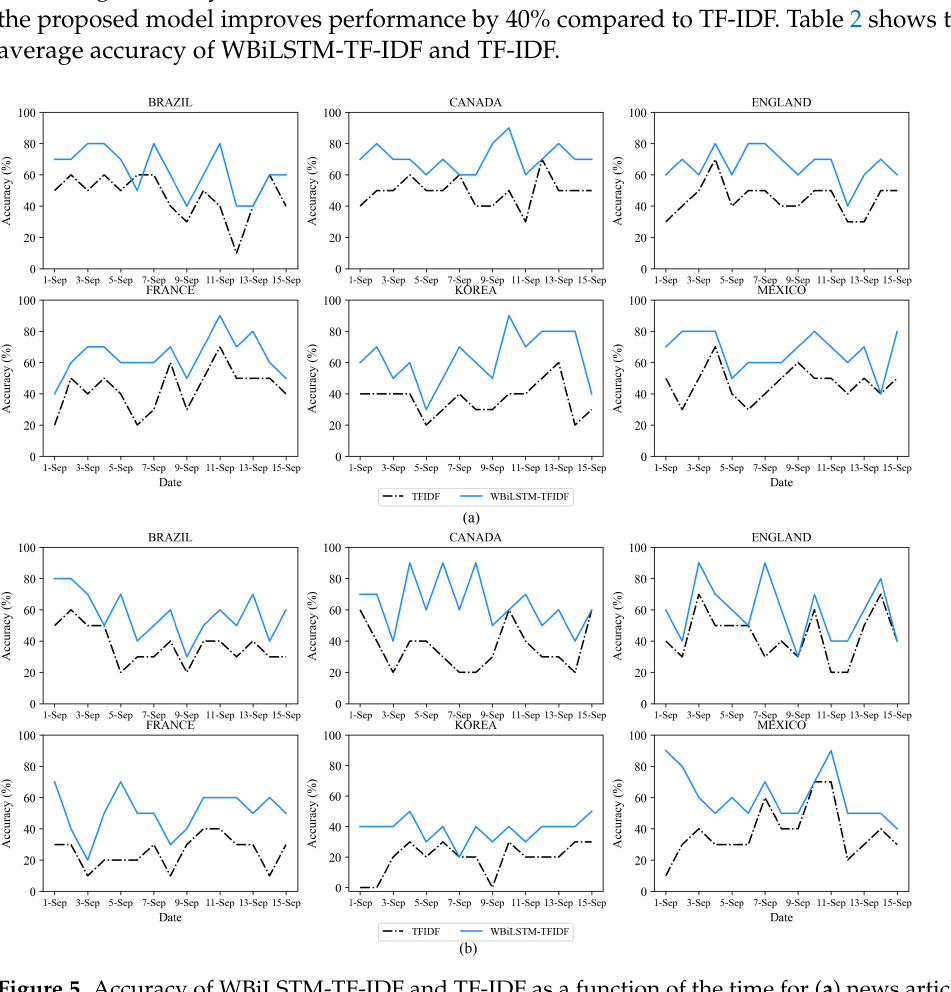
Figure 5. Accuracy of WBiLSTM-TF-IDF and TF-IDF as a function of the time for ( a ) news articles and ( b ) Twitter